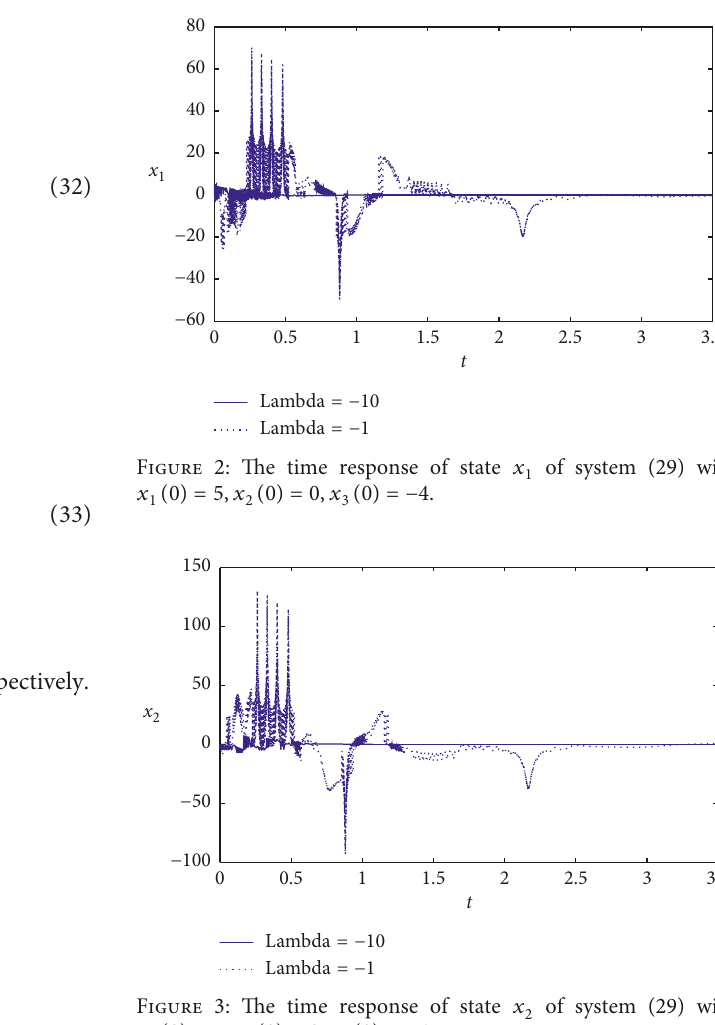
Figure 3: The time response of state x